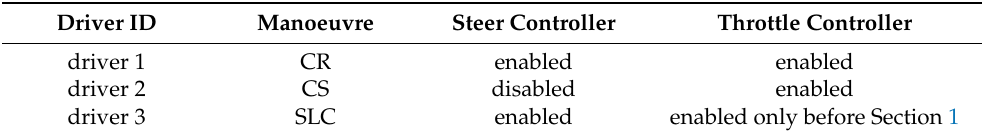
Table 3. Regulators’ activation status during the driving